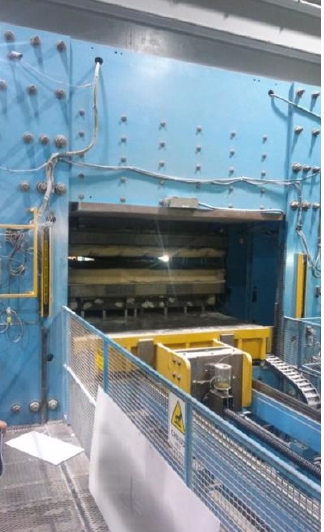
Figure 4. The hydraulic press used for the HSBF process.